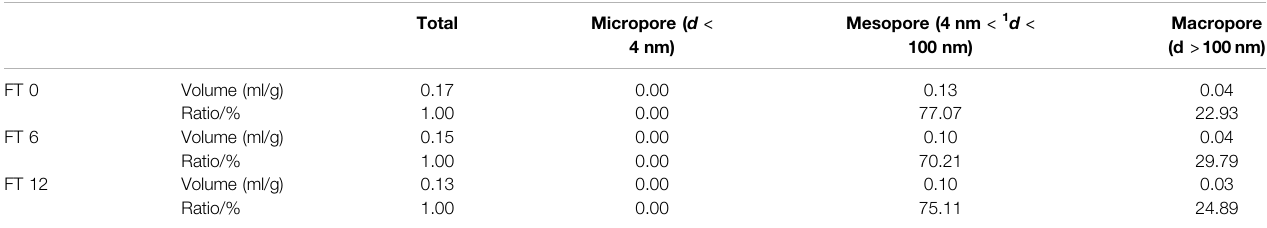
TABLE 4 | Pore size distributions of S/S sediments during FTs by